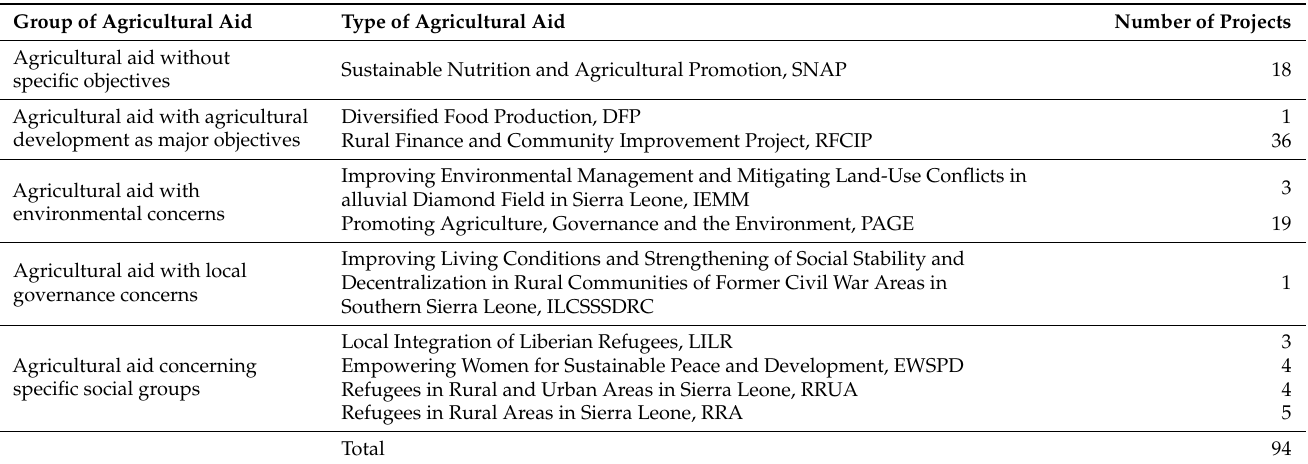
Table 1. Types of agricultural aid projects received in chiefdoms in Sierra Leone from 2001 to